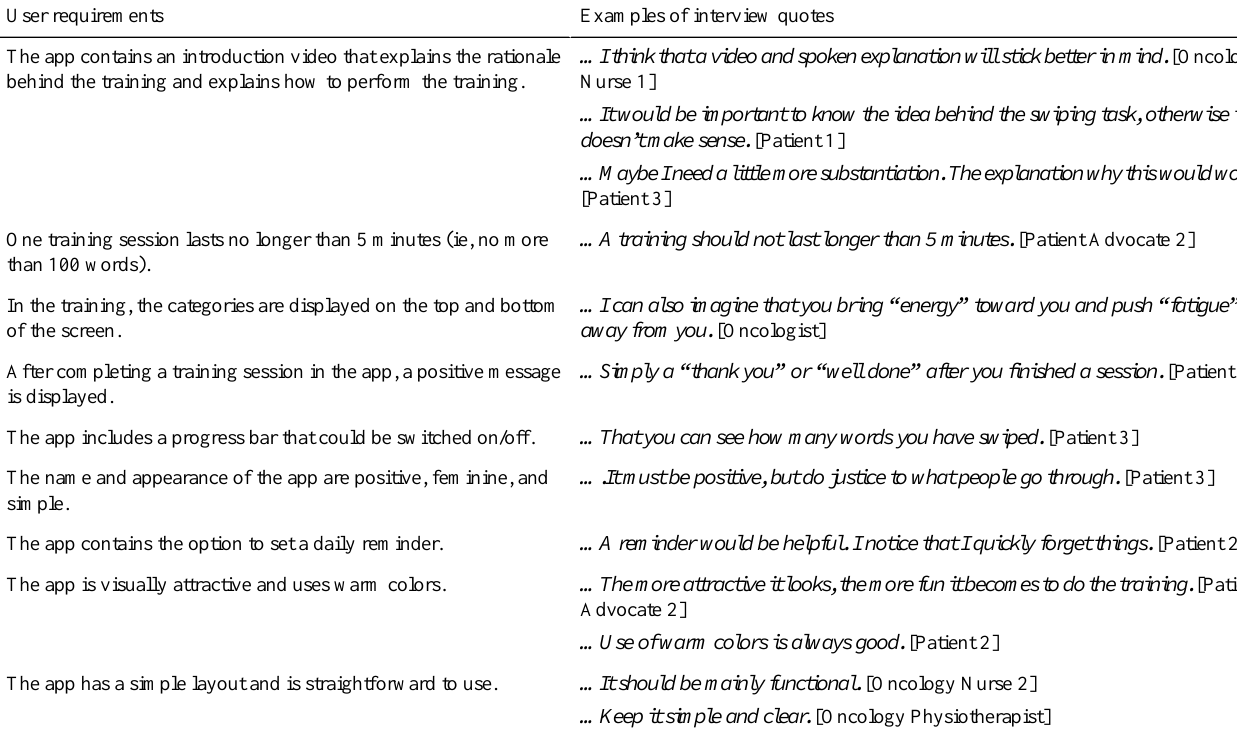
Table 2. User requirements for the training based on the interview outcomes.